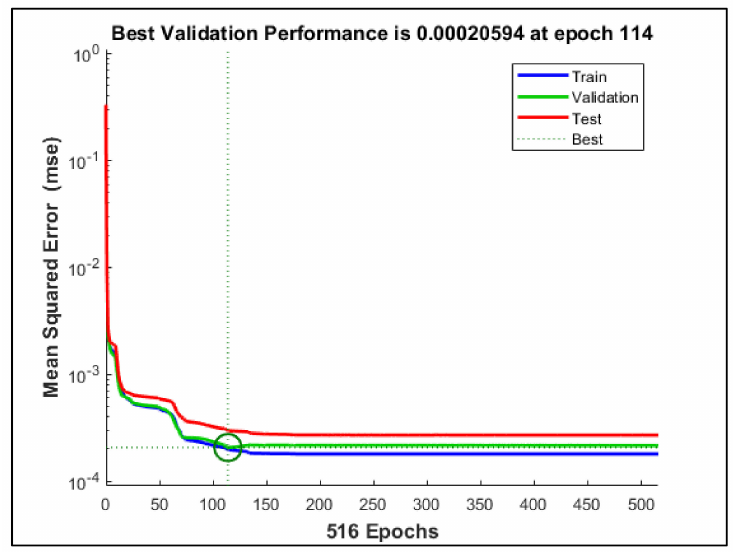
Figure 6. Regression plot of Model 7.